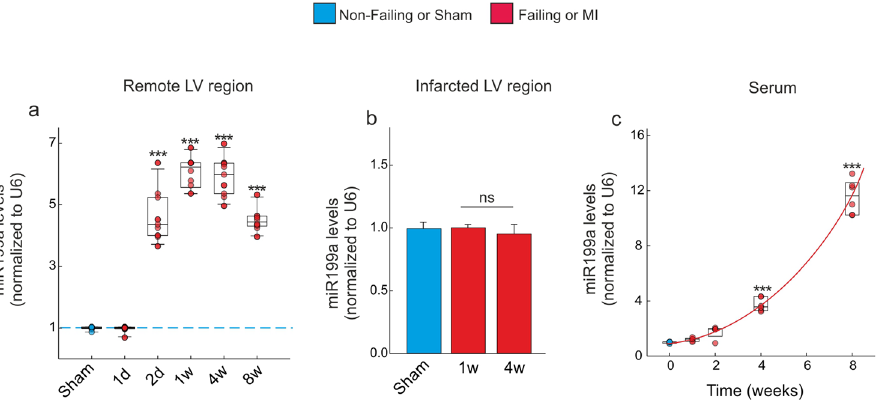
Figure 1. miR199a-5p is dynamically regulated following MI. ( a ) Quantification of miR199a levels by RT-qPCR in the remote LV region after MI. ( b ) Quantification of cardiac miR199a levels in the infarcted LV region by RT-qPCR. ( c ) Serum levels of miR199a after MI. n = 10 mice per groups. All quantitative data are reported as means ± SEM. ***P < 0.001 determined by two-way ANOVA followed by Bonferroni’s post hoc test. d: day(s); w: